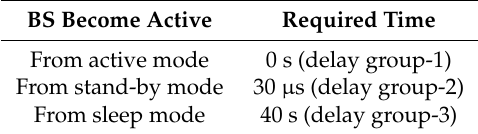
Table 3. Required time for a BS to become active (Hence approximate delay experienced by a new